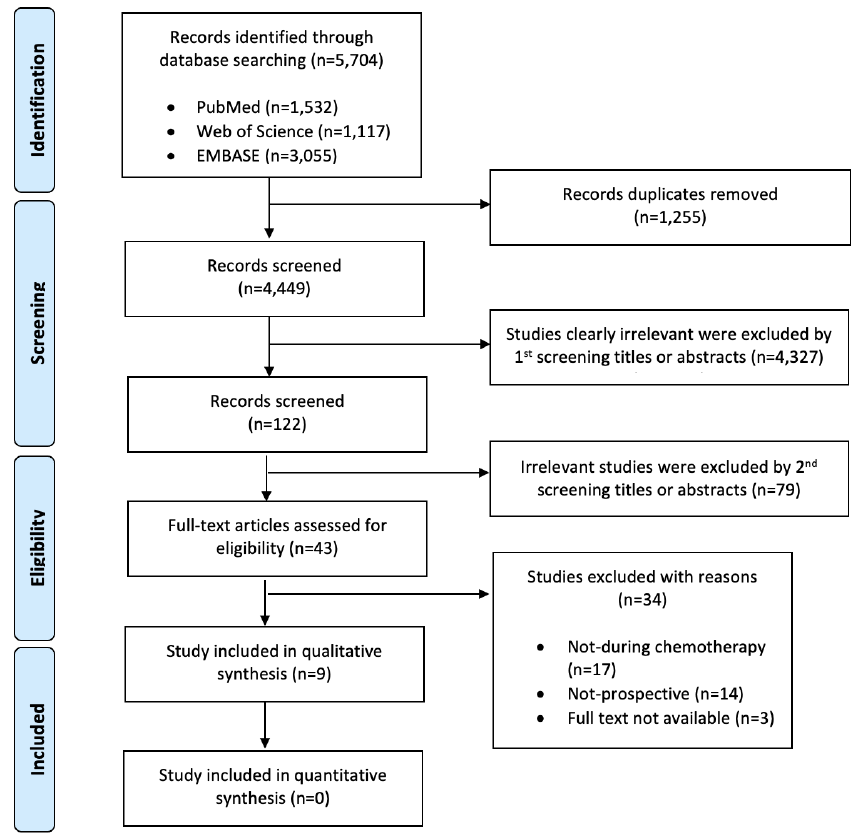
Figure 1. PRISMA Flow Diagram.